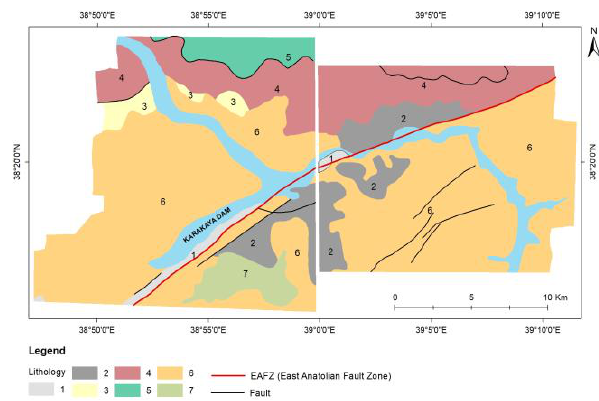
Figure 2. Lithological map (modified after Akbas et al., 2016).